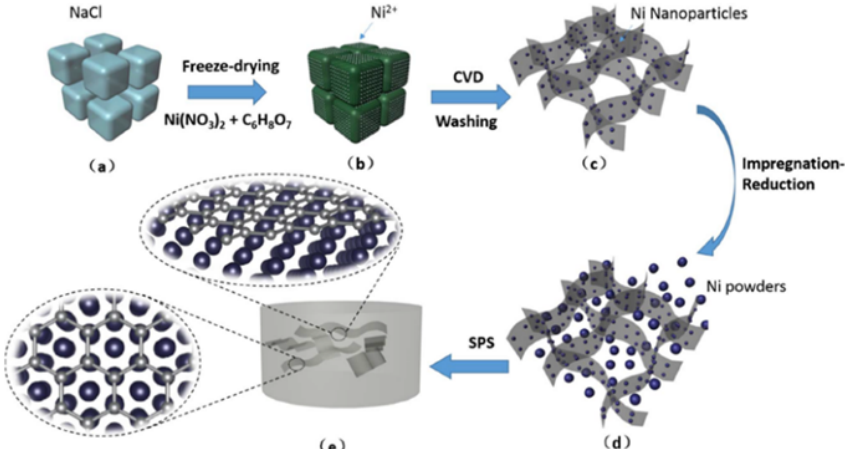
Figure 6: Schematic diagram of the process of 3D Ni-decorated GNS/Ni bulk composites: (a) NaCl crystals, (b) Ni(NO3)2-C6H12O6 coated NaCl by self-assembly after freeze-drying process, (c) Ni-decorated GNSs after CVD process and water washing, (d) Ni-decorated GNS/Ni composite powders after impregnation-reduction process, and (e) bulk composites fabricated by SPS. Reproduced from Reference